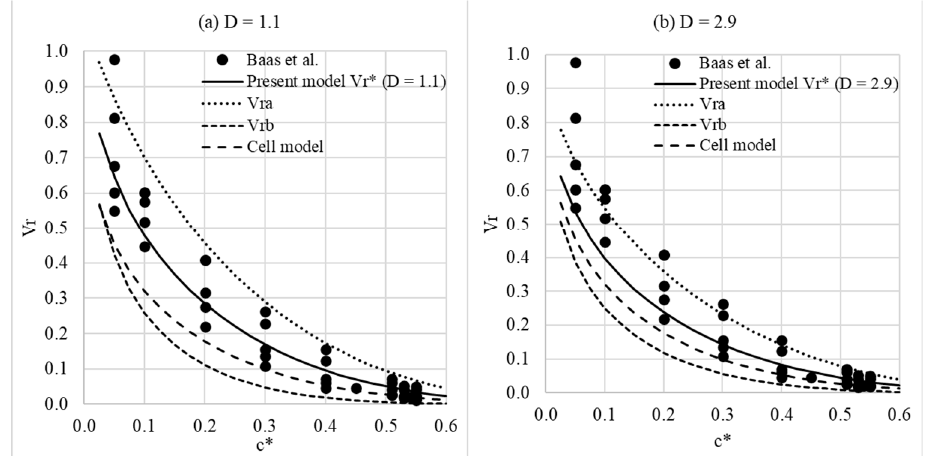
Figure 3. Comparison with recent experimental data from Baas et al. [4] for sedimentation of well- sorted spherical glass beads with ( a ) D = 1.1 and ( b ) D = 2.9. In ( a ) and ( b ), Vra = Vr* + s and Vrb = Vr* - s.